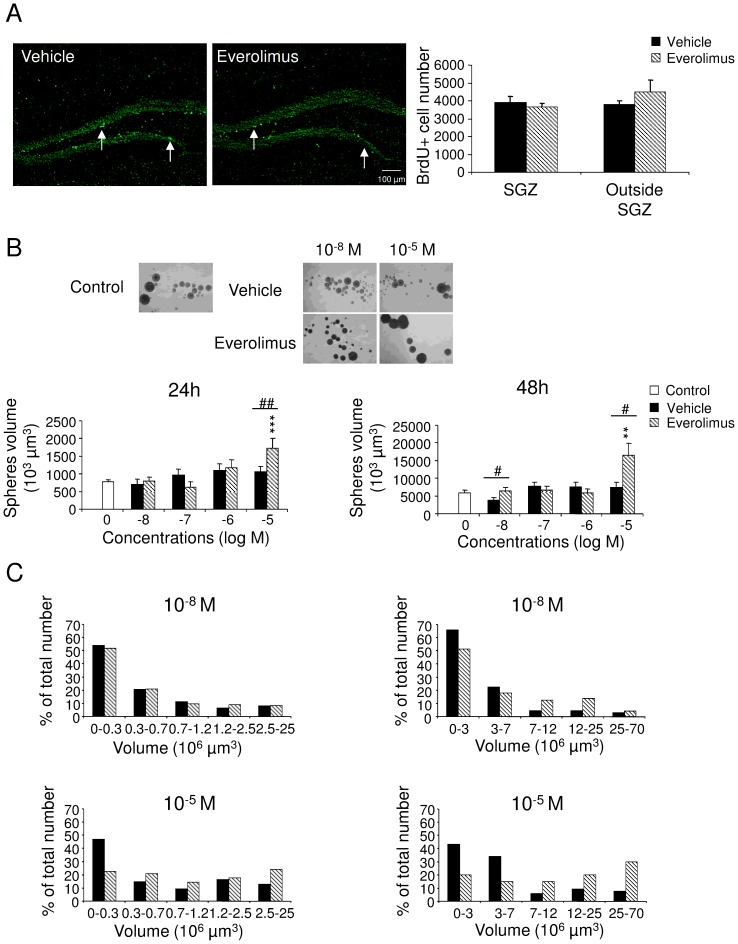
Effect of everolimus on precursor cell proliferation in vivo and in vitro.
(A) Effect of in vivo administration of everolimus on neural precursor cell proliferation in the hippocampus. Left, BrdU-positive cells (intense green cells, white arrows) were counted in the subgranular zone (SGZ) and the remaining part of the dentate gyrus (outside SGZ). Bregma −2.16 mm; Scale bar, 100 µm. Right, Number of BrdU+ cells in the SGZ or outside SGZ (Mann whitney U tests, p>.05). (B and C) Effect of increasing concentrations of vehicle and everolimus on neural stem cell growth in culture. (B) Upper, Phase-contrast image of floating neurospheres at 24 hours after treatment with vehicle and everolimus (10−8 and 10−5 M). Below, Neurosphere volume in the absence (control: 0) and presence of vehicle and everolimus after 24 hours and 48 hours of treatment (Kruskal-Wallis ANOVA followed by Dunn's tests ***p<.001 vs 0; Mann Whitney U-tests, #
p<.05,
##
p<.01 everolimus vs vehicle. Data represent means +SEM. (C) Proportion of neurospheres according to different categories of volumes. The increase of neurosphere mean volume might be explained by an increased proportion of bigger neurospheres and a decreased proportion of smaller neurospheres associated with everolimus treatment.